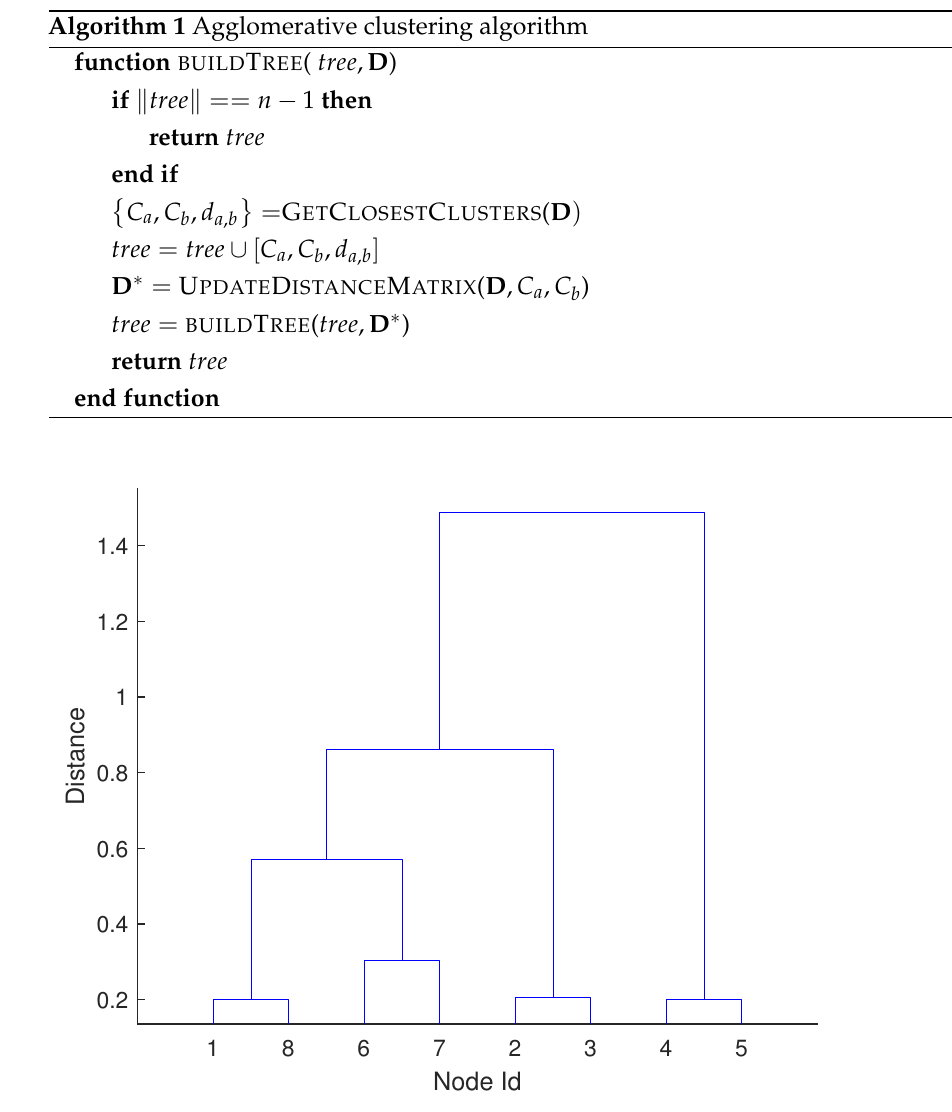
Figure 2. Example dendrogram tree